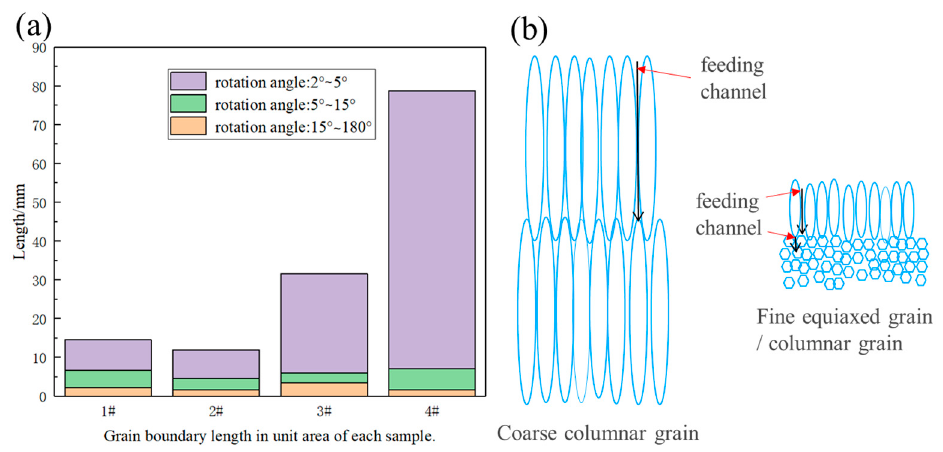
Figure 16. ( a ) Grain boundary length in unit area corresponding Figure 12, ( b ) Schematic diagram of grain boundary feed channel changes after